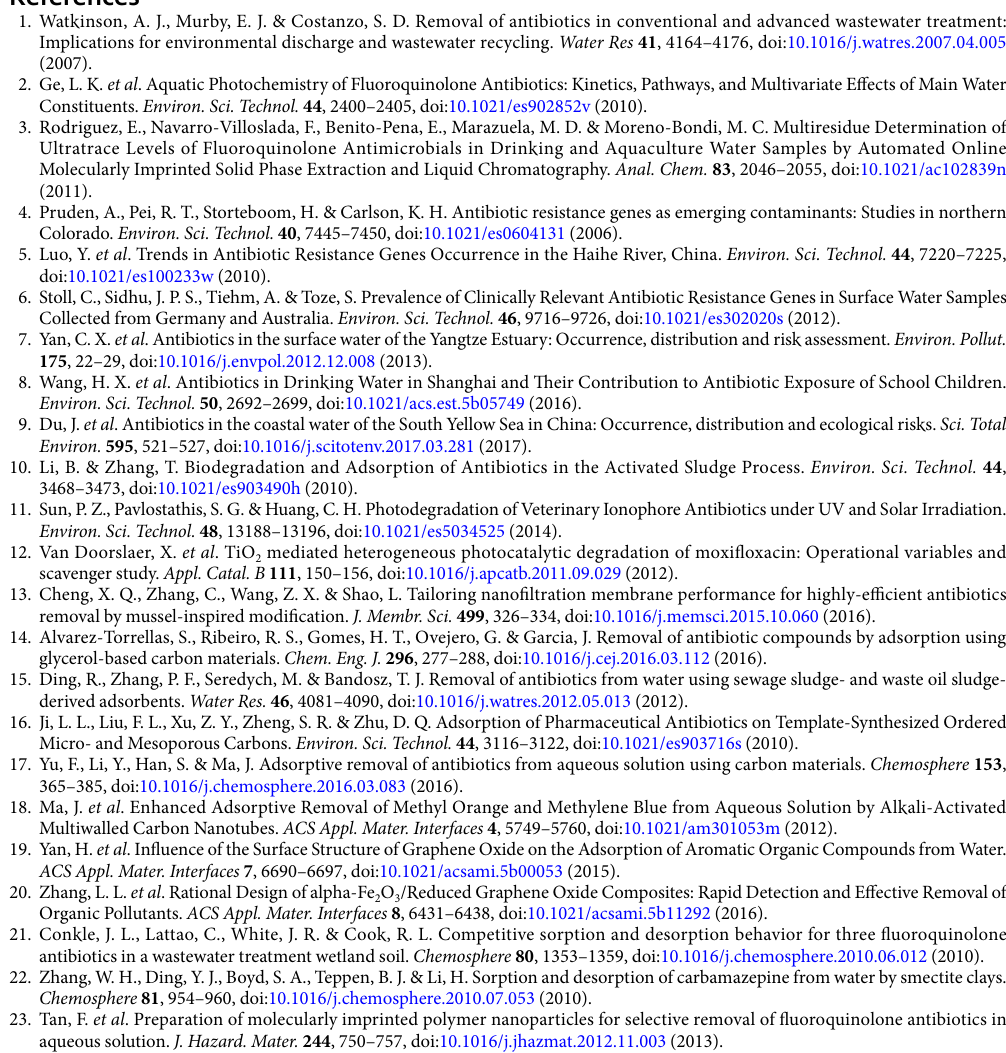
transfer of FQ molecules in the nanoparticles. The adsorption potential was mainly ascribed to the molecular recognition and electrostatic interactions between the molecules and the PDA film. The nanoparticles could be facilely separated by a magnet following the adsorption and was regenerated by simple washing. The nanoparti- cles could be used repeatedly for the removal of FQ antibiotics in seawater without loss of removal efficiency. The proposed method has potentials for efficient removal of antibiotics in environmental water.